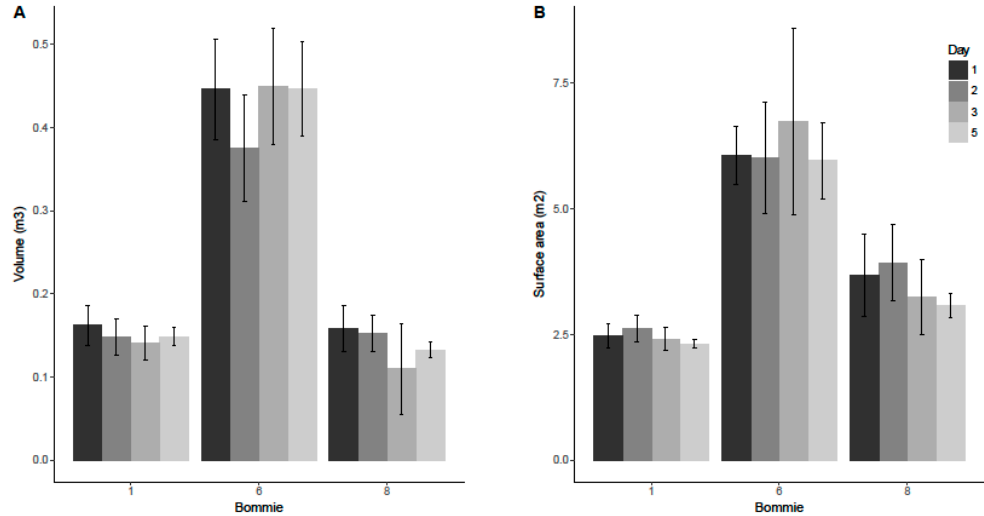
Figure 4. Mean ( A ) volume and ( B ) surface area ± 95% CI for three bommies measured four separate times over five days.